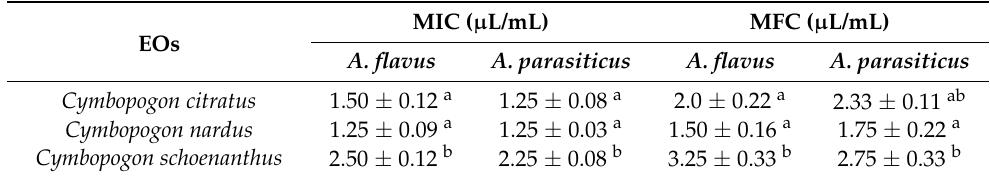
Table 5. Minimum inhibitory concentrations and minimum fungicidal concentrations of essential oils.